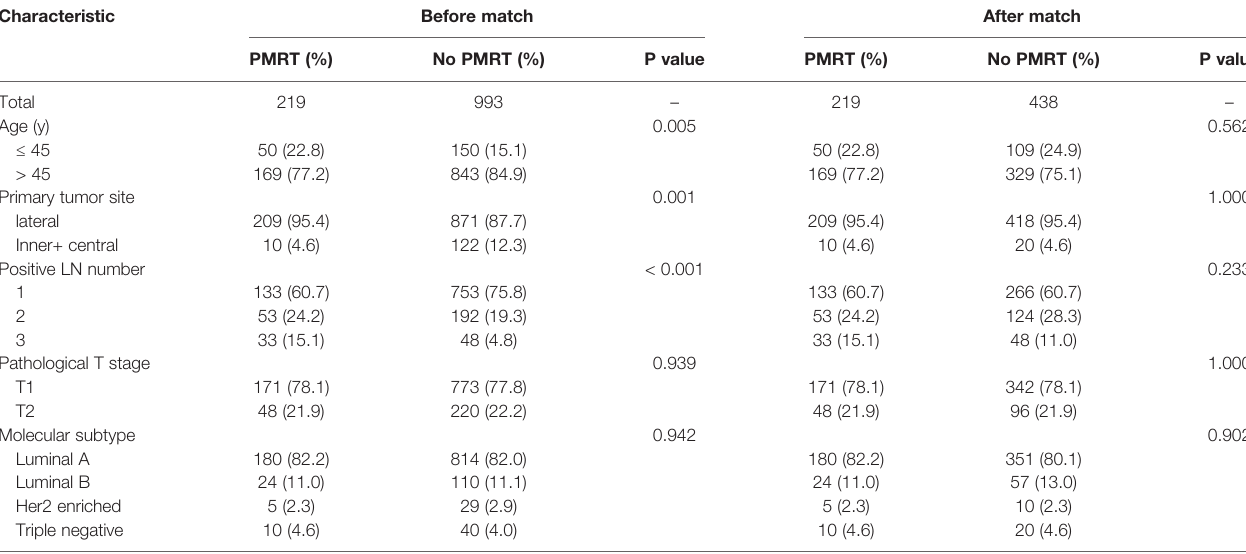
TABLE 4 | Clinical characteristics of low-risk patients with pT1-2N1M0 breast cancer before and after PSM 1:2 strati fi cation by treatment. Characteristic Before match After match